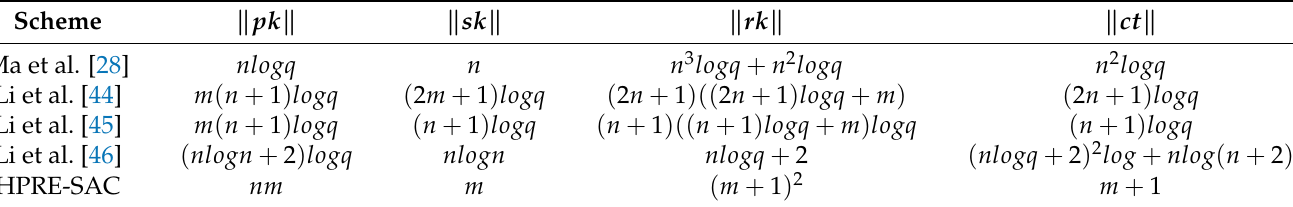
Table 3. The parameters comparison of HPRE schemes.